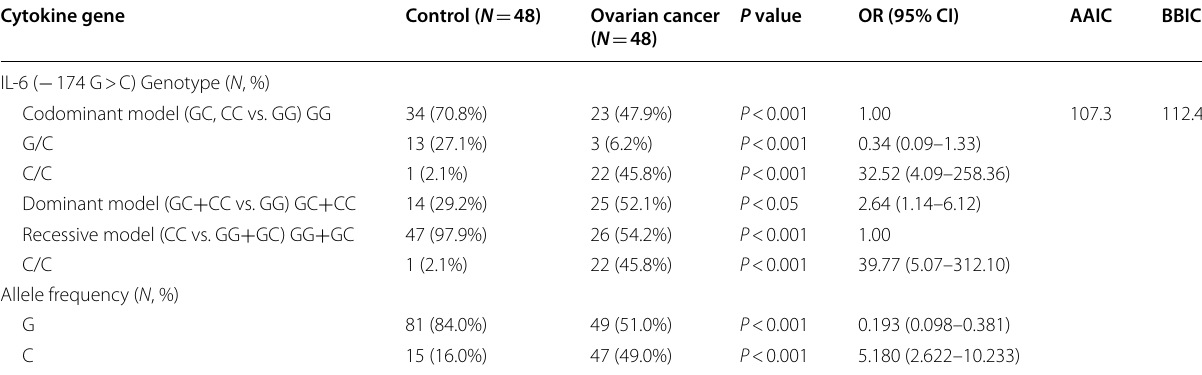
174G/C) in controls and patients with ovarian cancer −